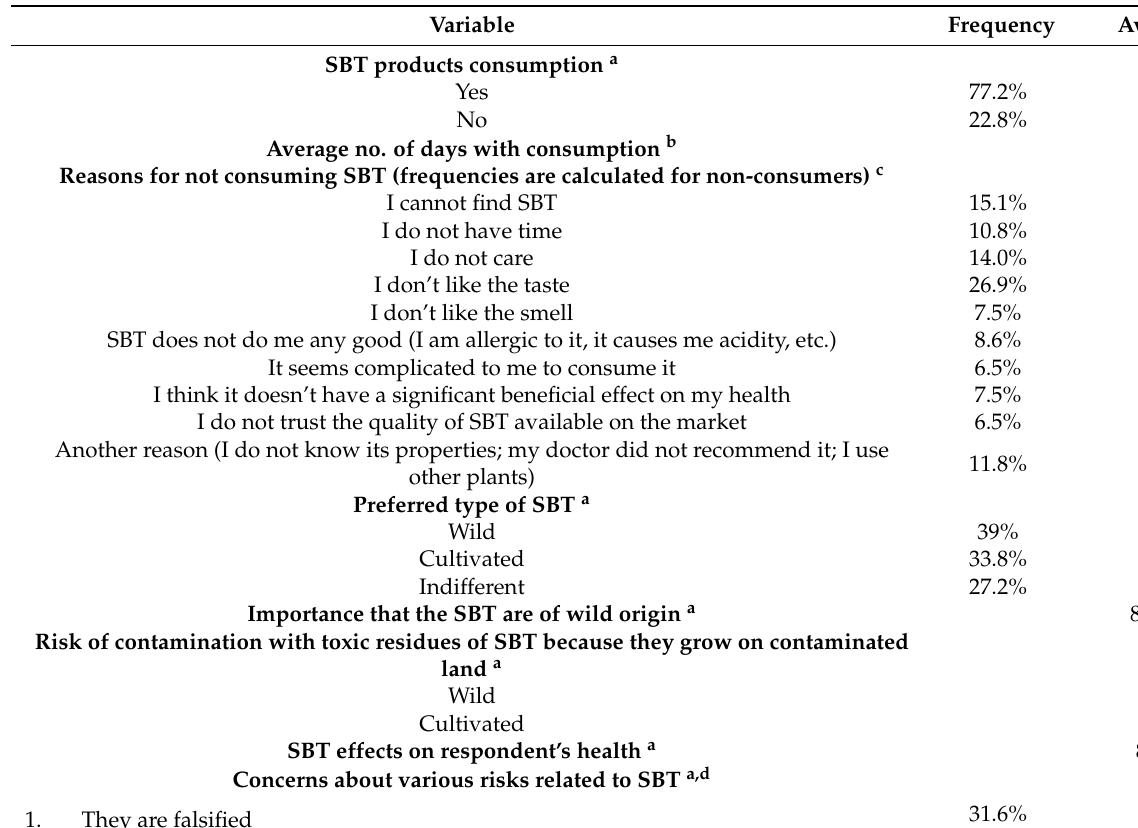
Table 2. Consumption preferences and perceived risks related to